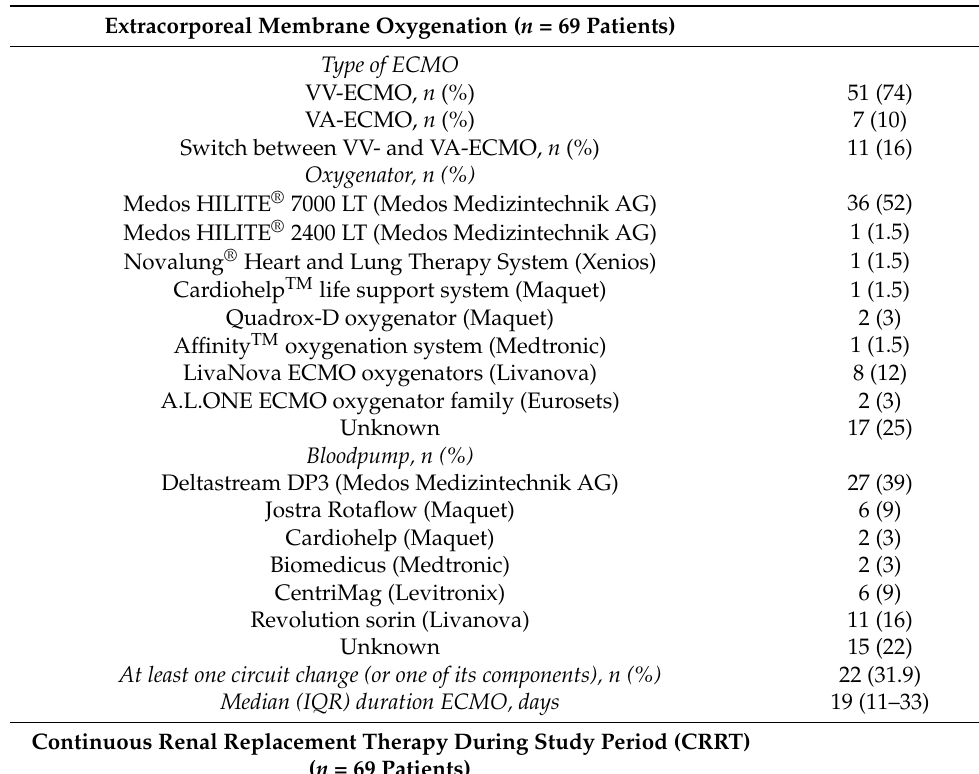
Table 1. Extracorporeal circuits. Extracorporeal Membrane Oxygenation ( n = 69